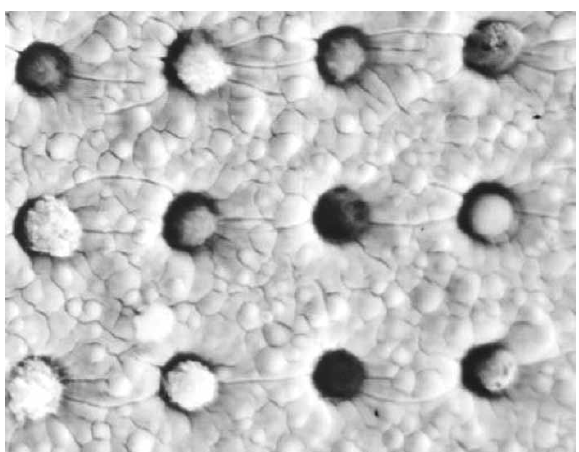
Figure 1. An electron micrograph of lymphocytes trapped on the Cellcarrier.